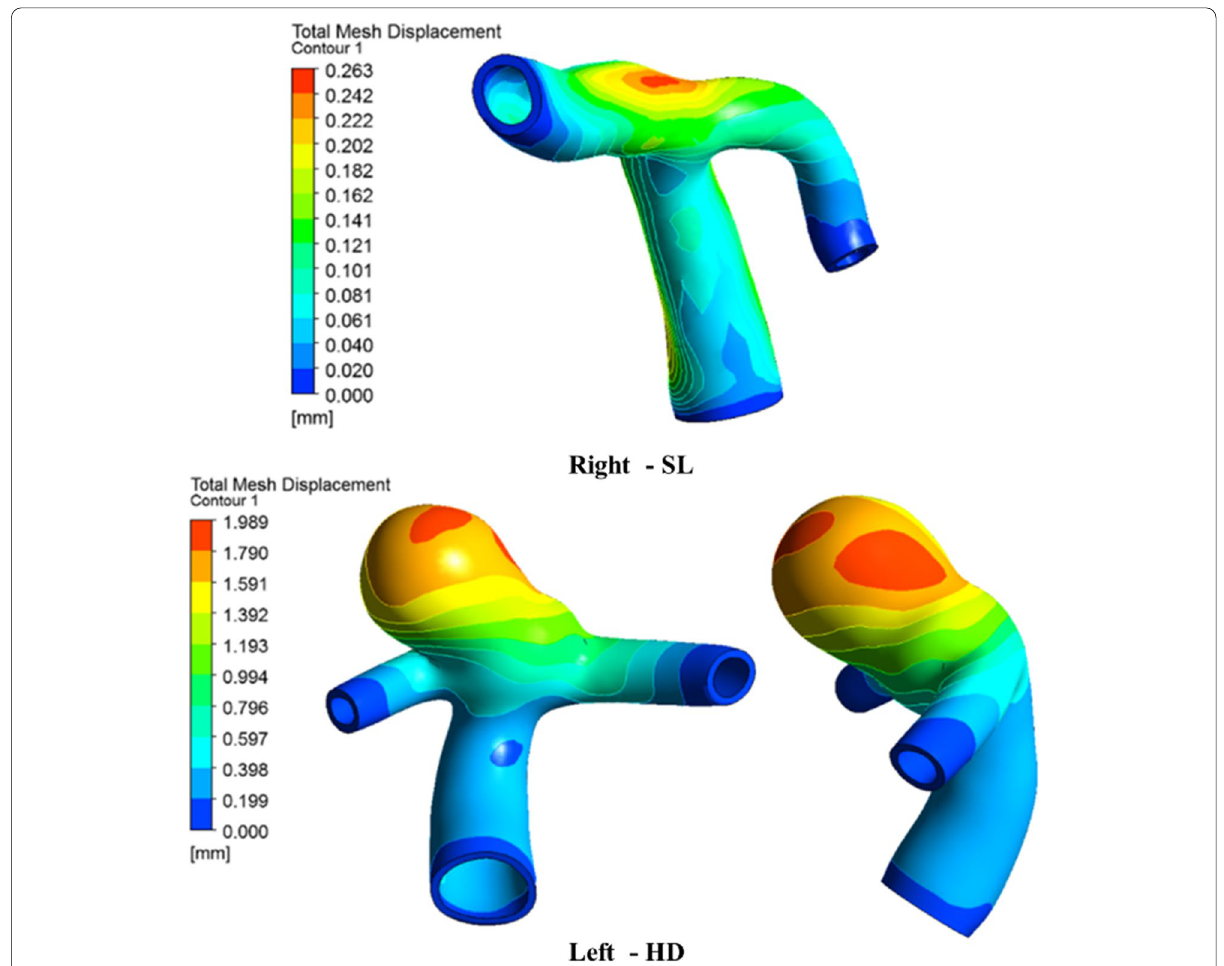
Fig. 12 Comparison of wall deformation contours during peak